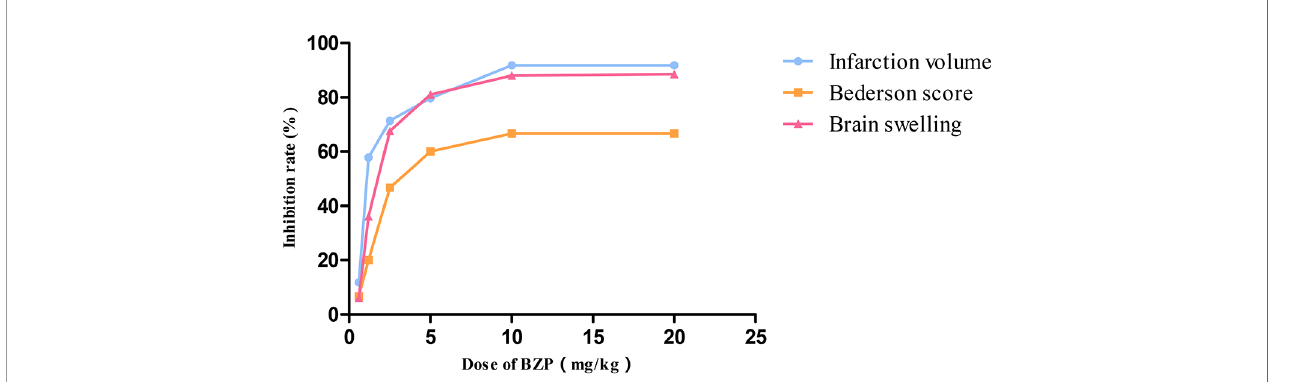
FIGURE 2 | The dose-response curve of Neurologicalde fi cit score, infarction volume, and brain swelling after occlusion-reperfusion on post-ischemic treatment with BZP. X bar represents the dose of BZP, Y bar represents the inhibition rate.